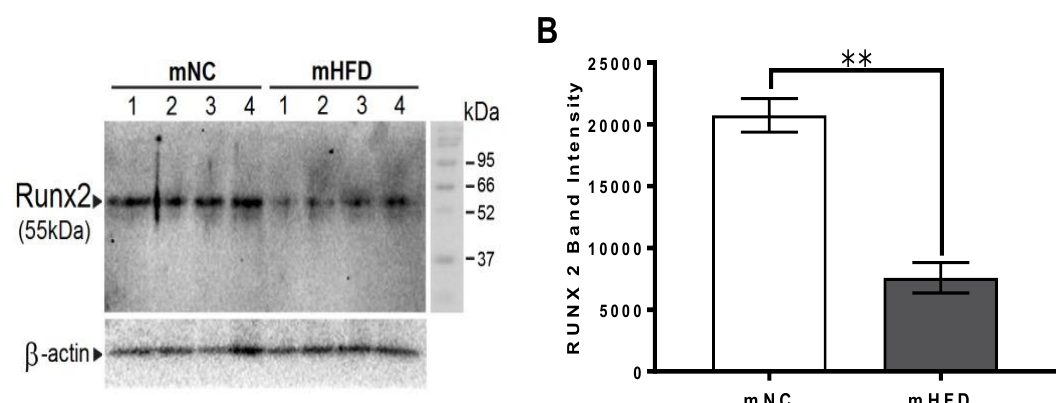
Figure 7. The high fat diet decreased runt-related transcription factor 2 (Runx2) protein expression in the femora of mature mice. ( A ) Western blotting of Runx2 protein expression in the right tibia flushed of bone marrow in mature normal chow (mNC) and mature high fat diet (mHFD) mice ( n = 4 in each group). ( B ) Runx2 band intensity acquired using the BioRad ChemiDoc imaging system and band intensity quantified using ImageJ. Results are presented as mean ± SEM, ** represents p < 0.01, (unpaired t -test).